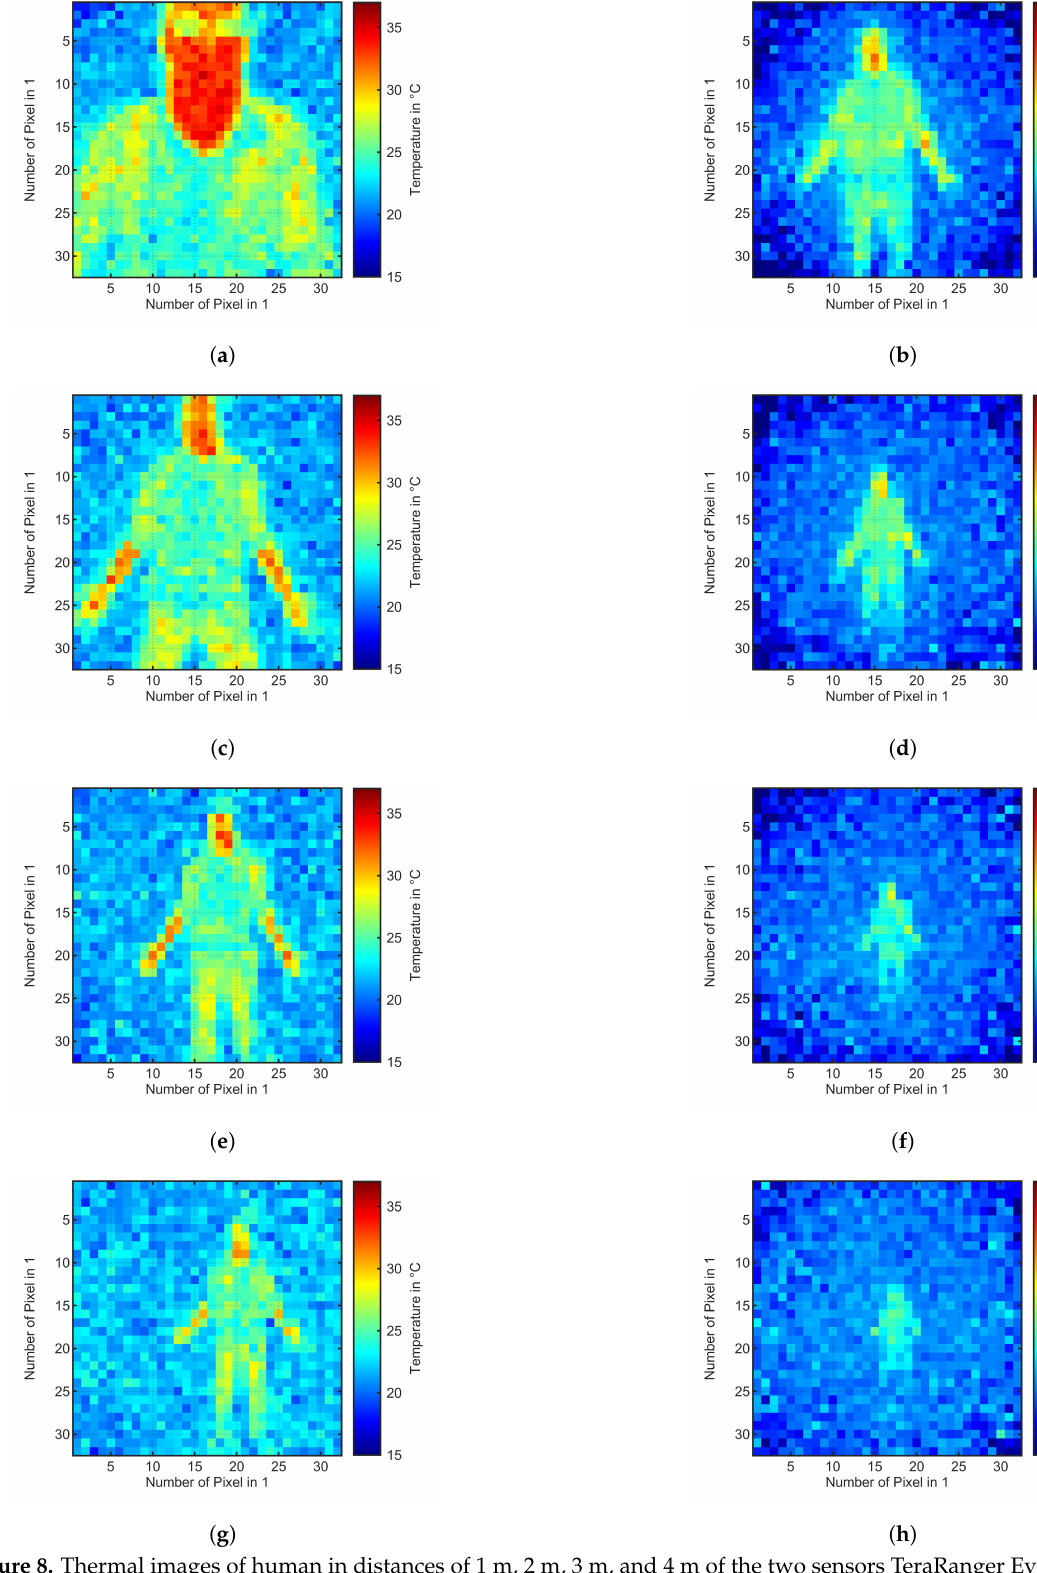
Figure 8. Thermal images of human in distances of 1 m, 2 m, 3 m, and 4 m of the two sensors TeraRanger Evo Thermal 33 and 90. ( a ) Human in 1 m distance of Evo Thermal 33; ( b ) Human in 1 m distance of Evo Thermal 90; ( c ) Human in 2 m distance of Evo Thermal 33; ( d ) Human in 2 m distance of Evo Thermal 90; ( e ) Human in 3 m distance of Evo Thermal 33; ( f ) Human in 3 m distance of Evo Thermal 90; ( g ) Human in 4 m distance of Evo Thermal 33; ( h ) Human in 4 m distance of Evo Thermal